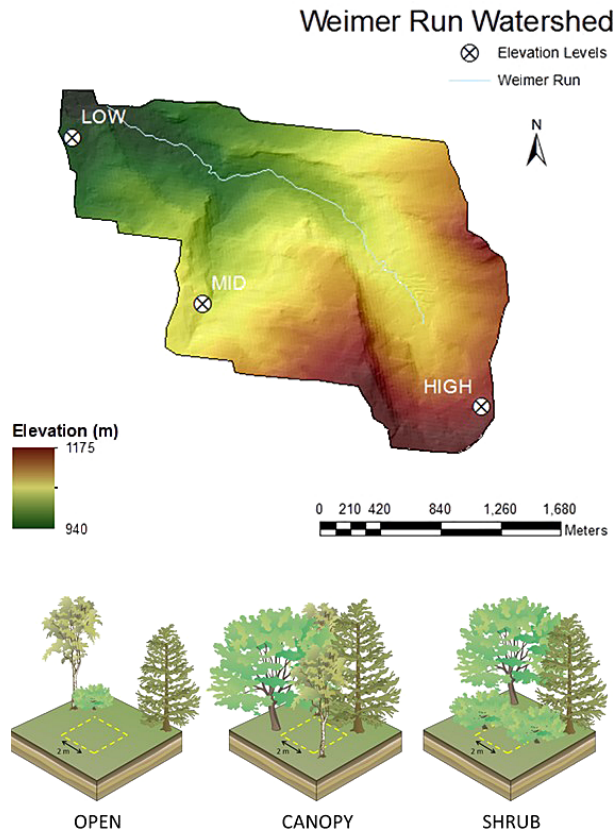
Figure 1. Above: Weimer Run watershed (374ha) with elevation levels indicated on map. Below: conceptual diagram showing veg- etation classes. Images courtesy of the Integration and Application Network, University of Maryland Center for Environmental Science